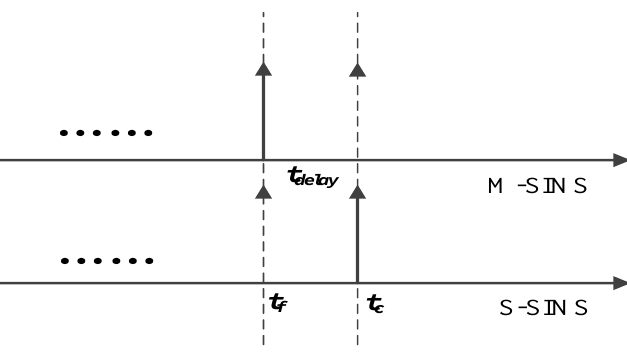
Figure 1. Schematic diagram of time delay.